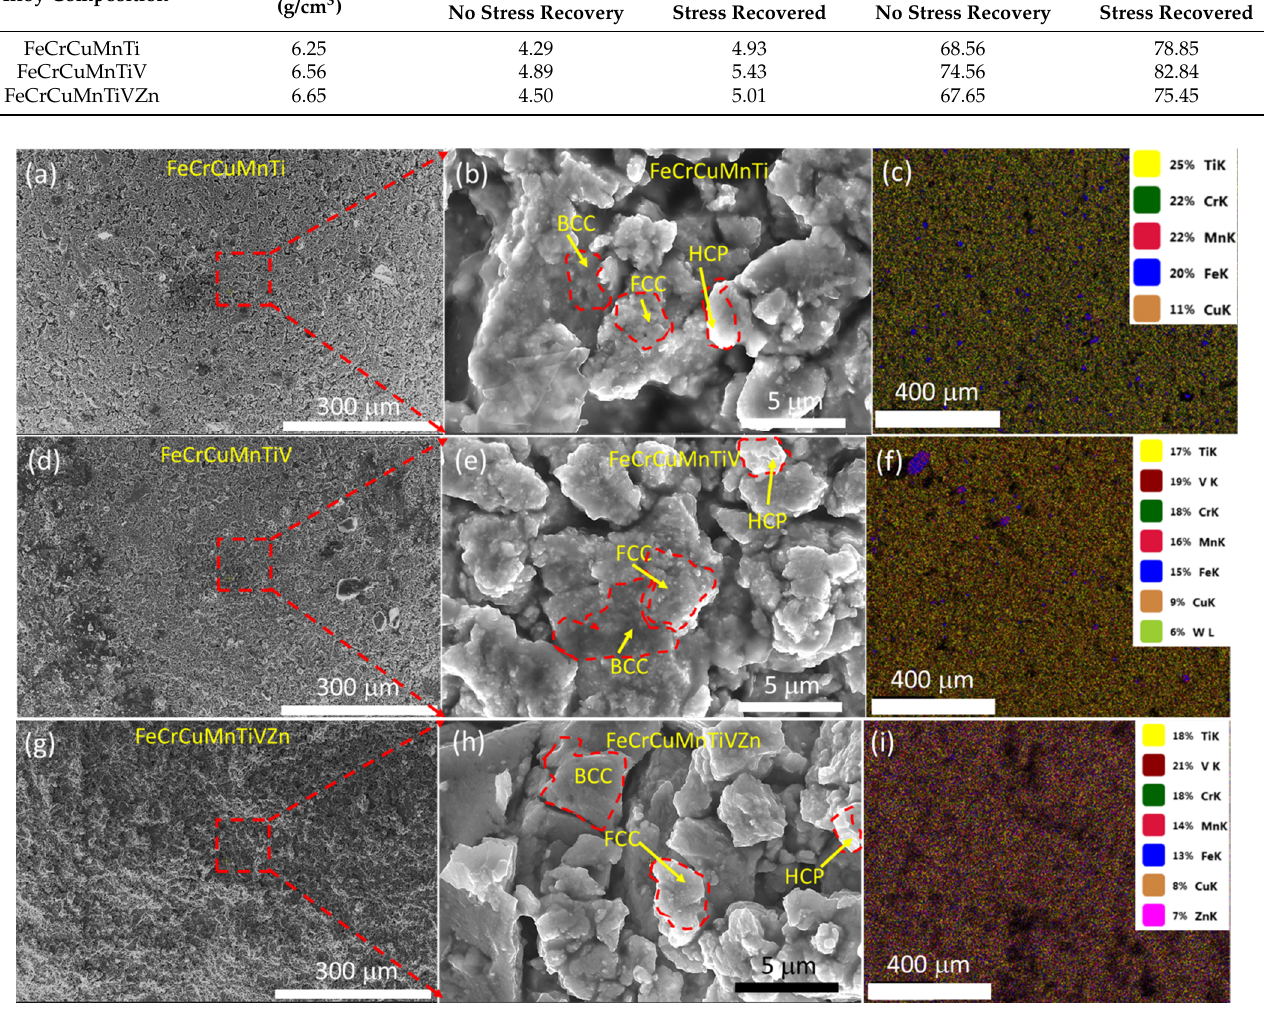
Table 4. Theoretical density, green density, and relative density of three developed HEAs measured at 1100 MPa. Alloy Composition